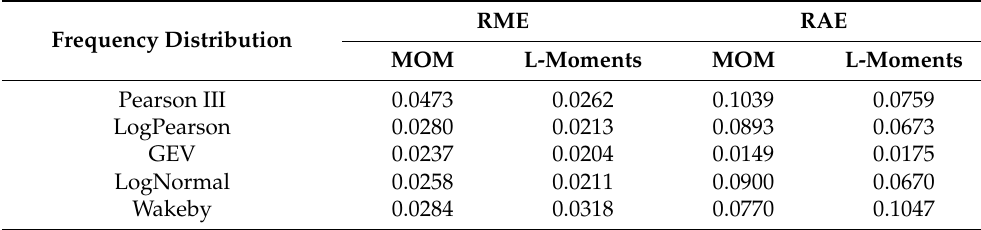
Table 8. RME and RAE score values for the Prigor river.